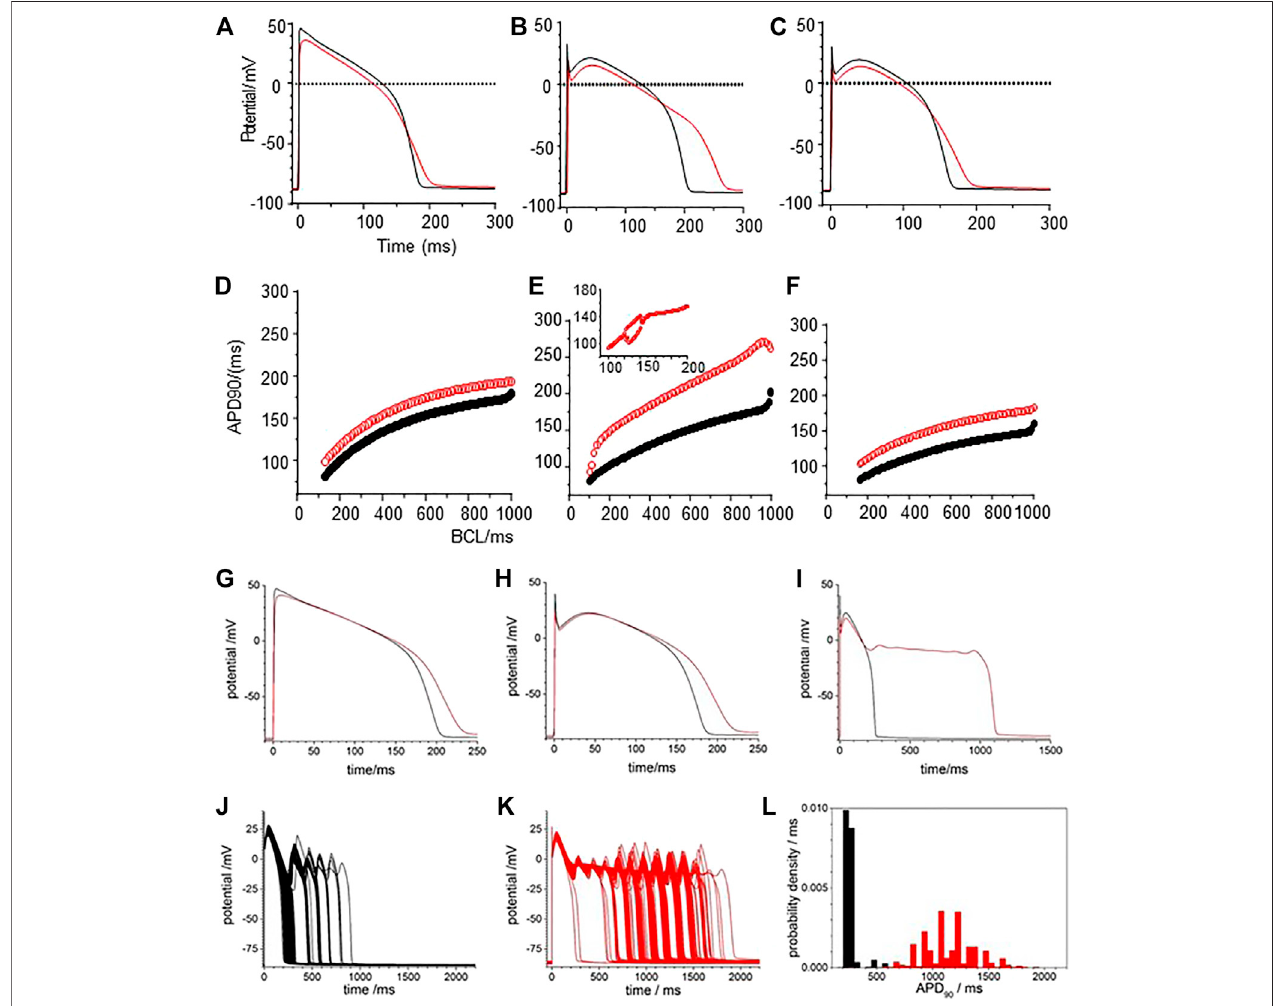
FIGURE 4 | CO prolongs APD90 in LRd (1994) ventricular cell models. Periodic action potentials at BCL of 1 s for (A) endo-, (B) midmyo (C) epi-myocardial cell models 100th action potential at BCL of 1 s and (D – F) dynamic restitution curves for endo-. midmyo- and epi-cardial cell models. Oscillatory EADs develop in mid- myocardial, but not epi- and endo-, cell models a BCL of 6 s 100th triggered action potentials at BCL of 6 s for (G) endo-, (H) epi- and (I) mid-myocardial cell models. 1,000 superimposed action potentials, each the 100th action potential at a BCL of 6 s, for standard LRd midmyocardial model with all the current magnitude parameters Gaussian distributed with a 5% standard deviation about (J) its standard values (K) modi fi ed for the effects of CO. (I) Probability density histograms for APD 90 of midmyocardial action potentials. Red: with CO parameters, black standard